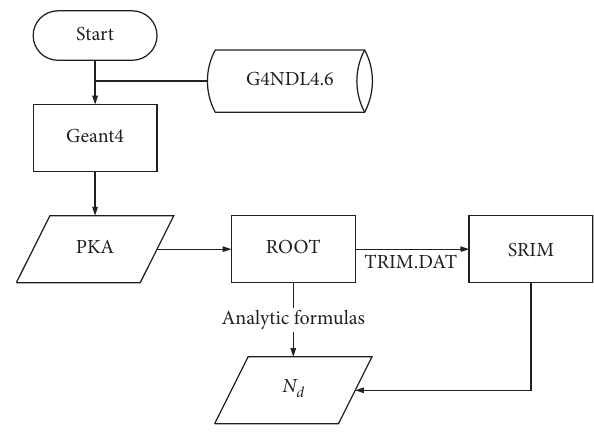
Figure 1: Calculation process of N